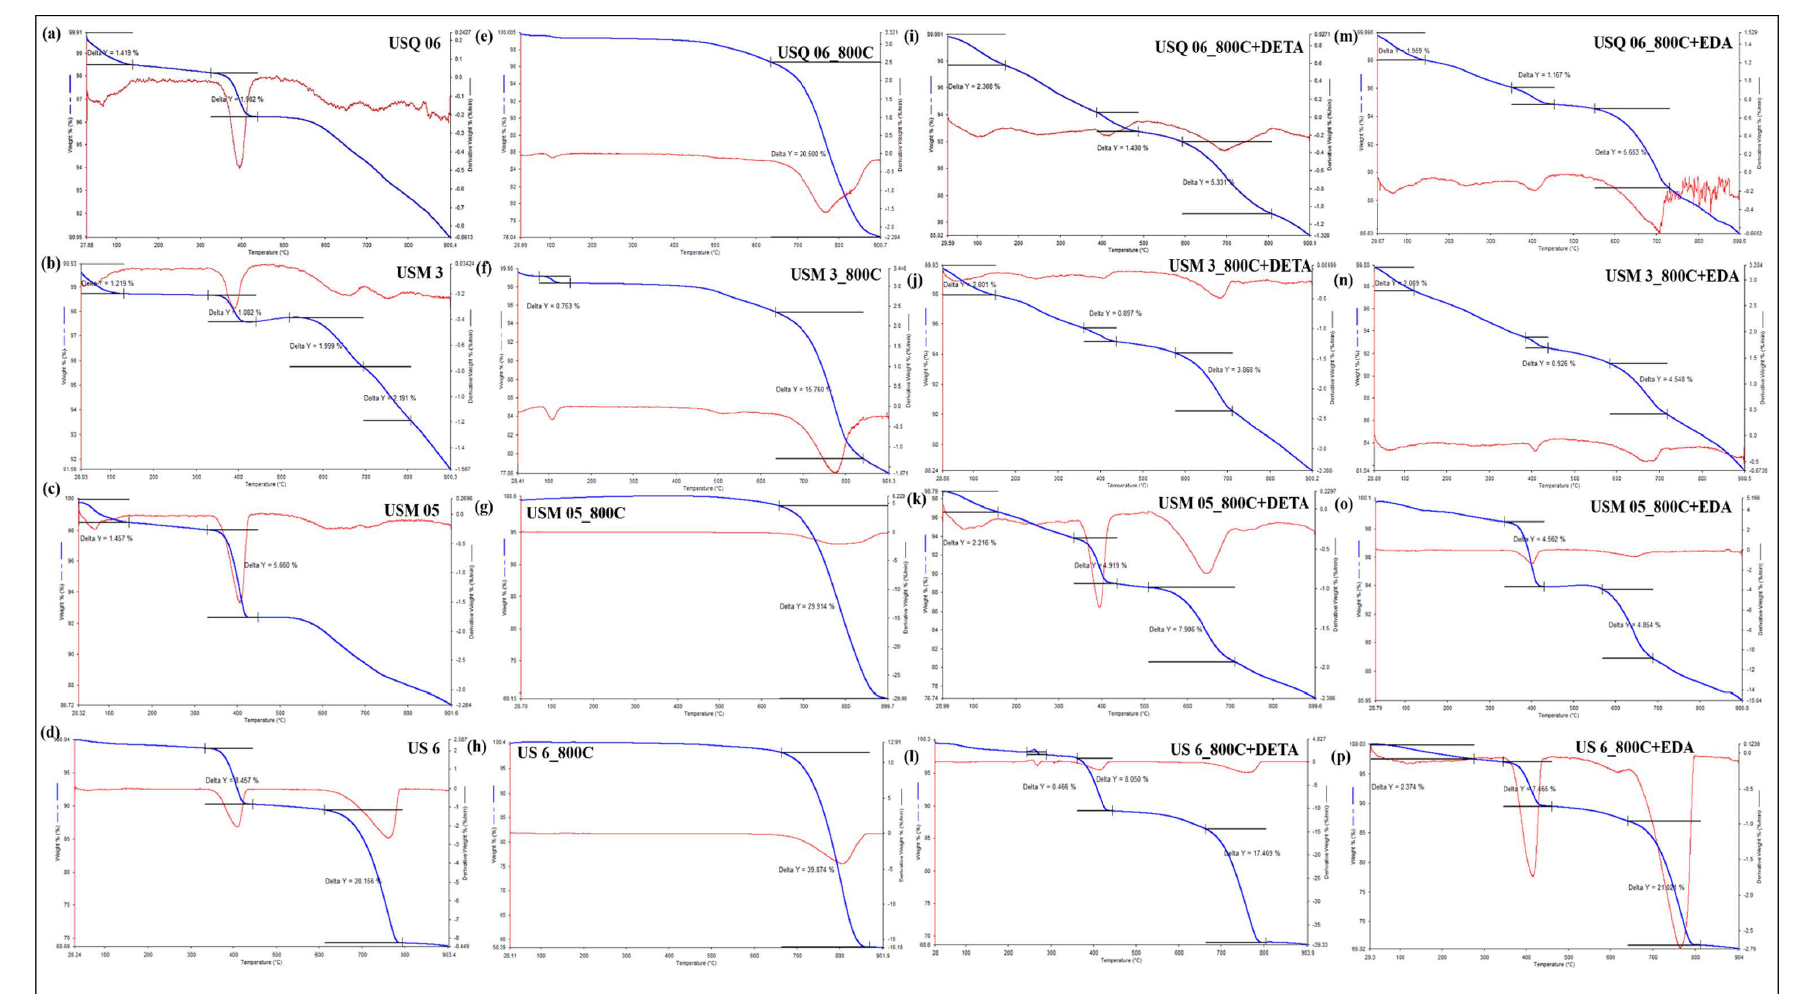
Figure 7. The thermal stabilities of Raw shale ( a – d ), spent shale ( e – h ), DETA-modified spent shale ( i – l ), and EDA-modified spent shale ( m – p ) at up to 900 ◦